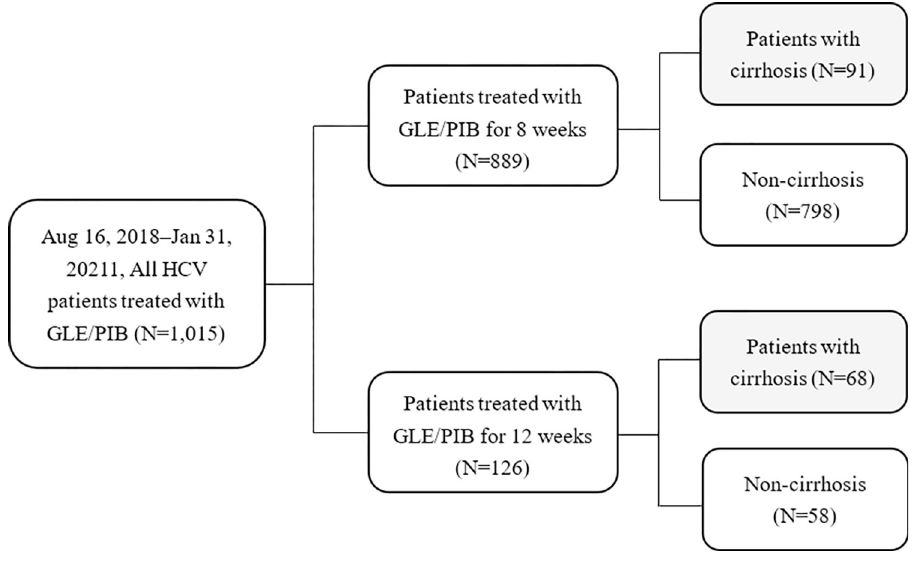
Fig 1. Study flow